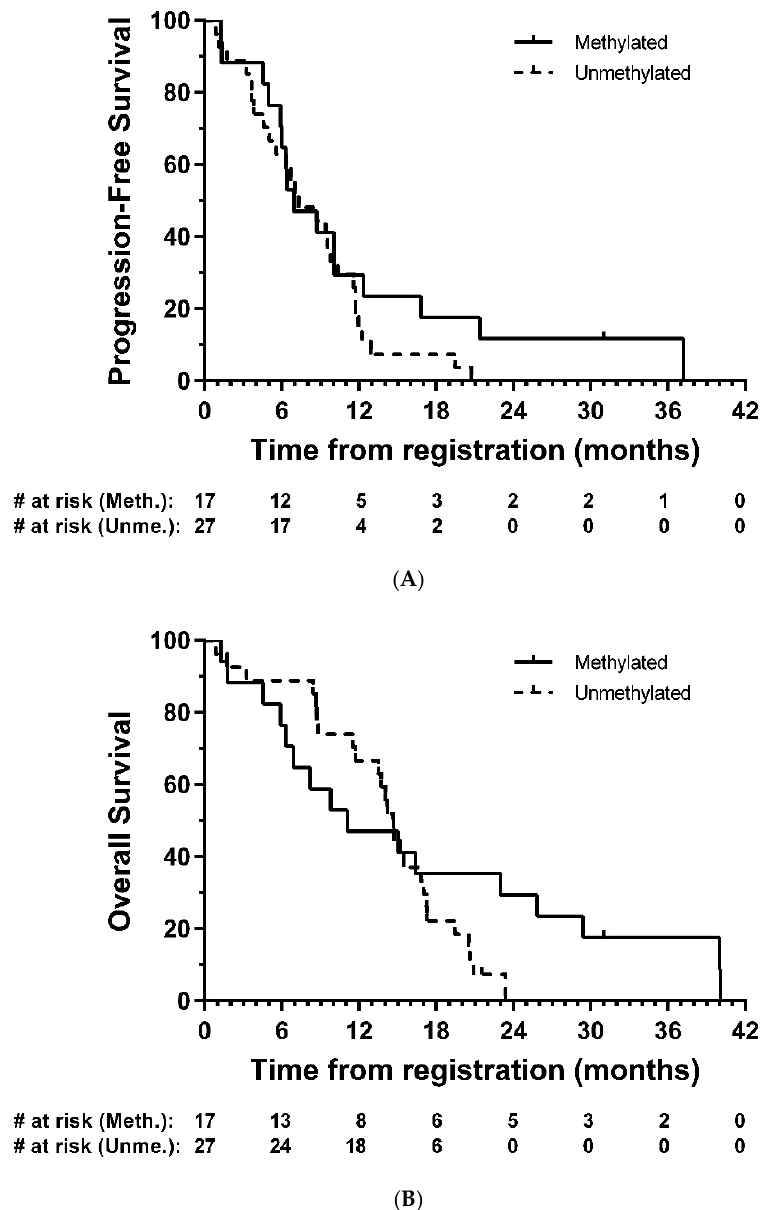
Figure 4. Kaplan–Meier plots of ( A ) progression-free and ( B ) overall survival—eligible patients, by MGMT methylation group. # =